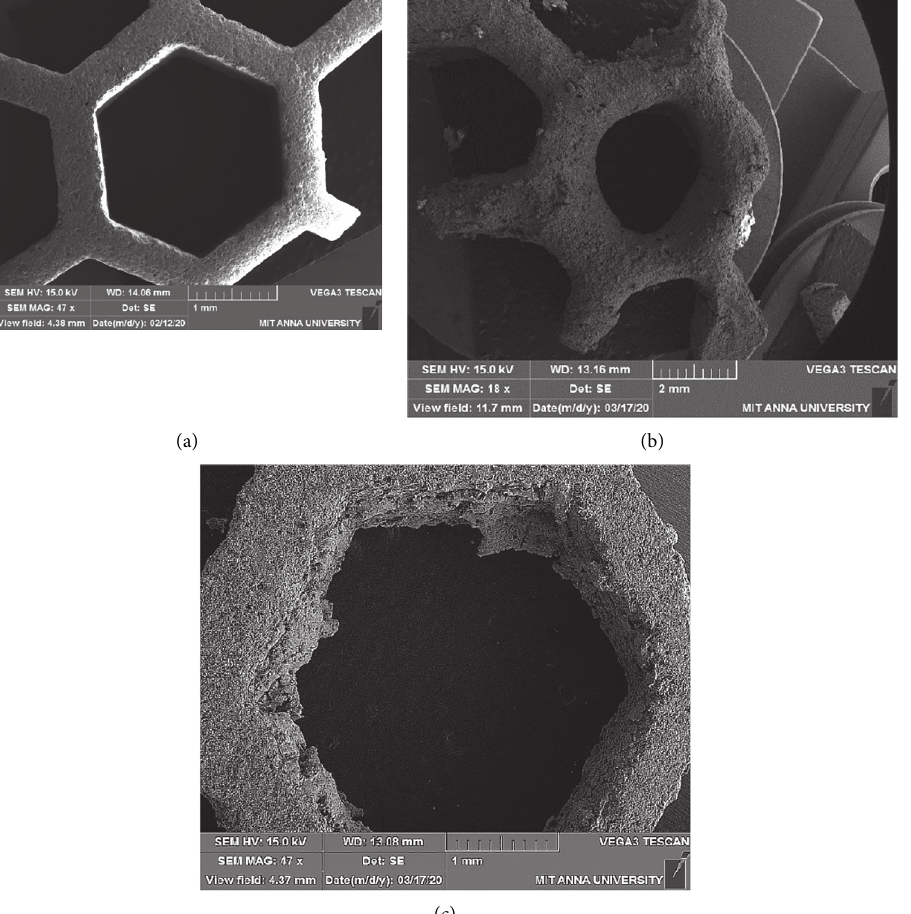
Figure 6: SEM images cordierite. (a) Uncoated cordierite. (b) First coating. (c) Second coating.